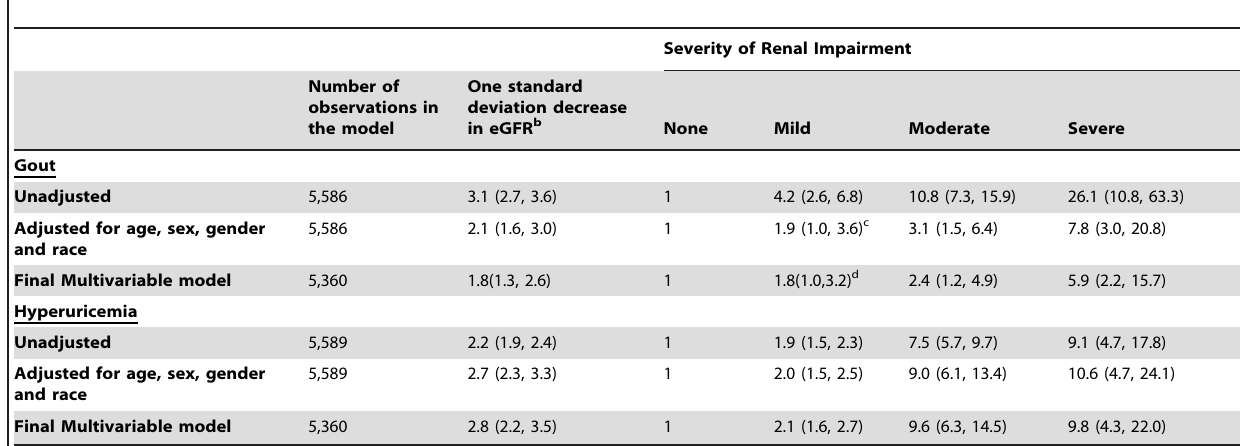
Table 6. Results of logistic regression analyses of the risk for gout and hyperuricemia by renal impairment.